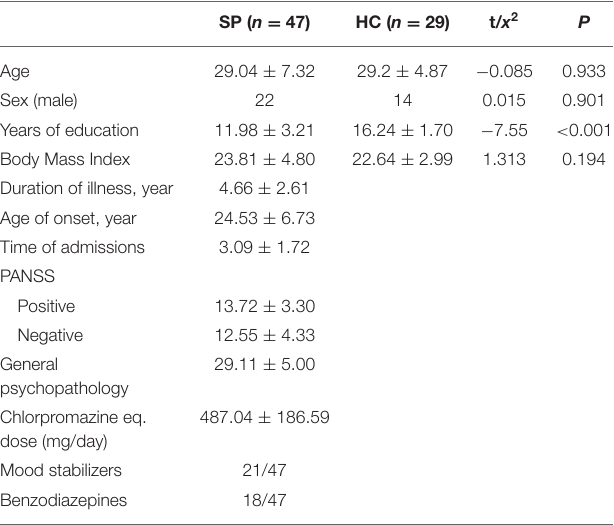
TABLE 1 | Demographic and clinical characteristics of schizophrenia (SP) and healthy control (HC) groups.